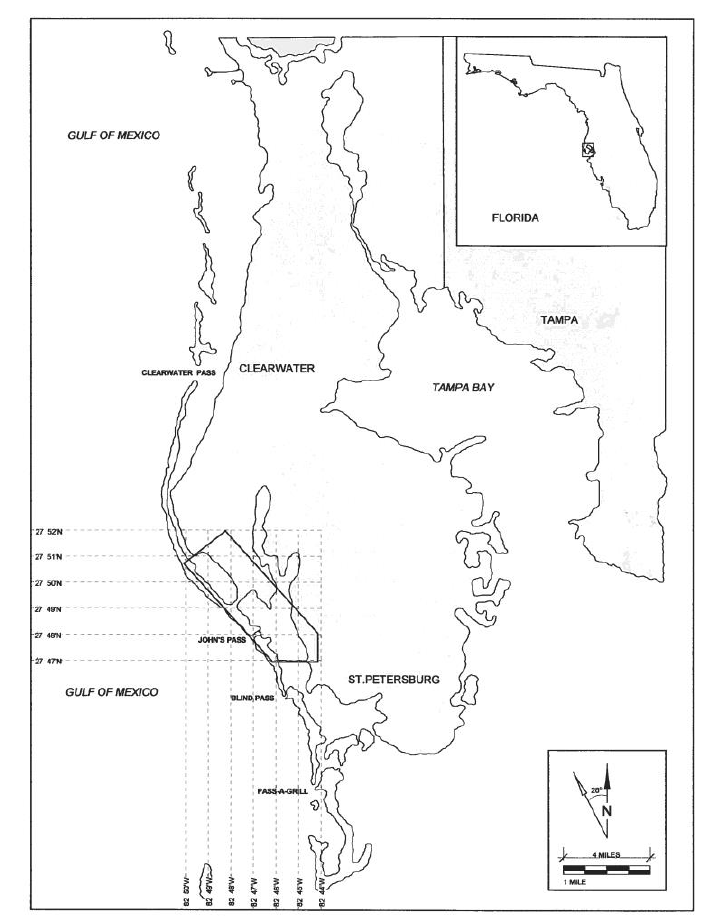
Figure 2. John’s Pass study area, north end N 27º 49.949, W 82º 49.491; south end N 27º 46.333, W 82º 45.215. The study area is a 6.5 sq mi portion of a continuous estuarine ICW Boca Ciega Bay system. John’s Pass is located at N 27º 47.109, W 82º 46.803. There are about 10 mi of coastline for every mile of water (coastline 62.88 mi long), created by numerous waterways and 51 cul-de-sac “fingers” of water hardened by seawalls. Average water depth is 7 ft; the majority of the study area ranges from less than 1 ft off sandbars to depths of about 22 ft (6 m). John’s Pass is the deepest area, about 20-40 ft deep (6-12